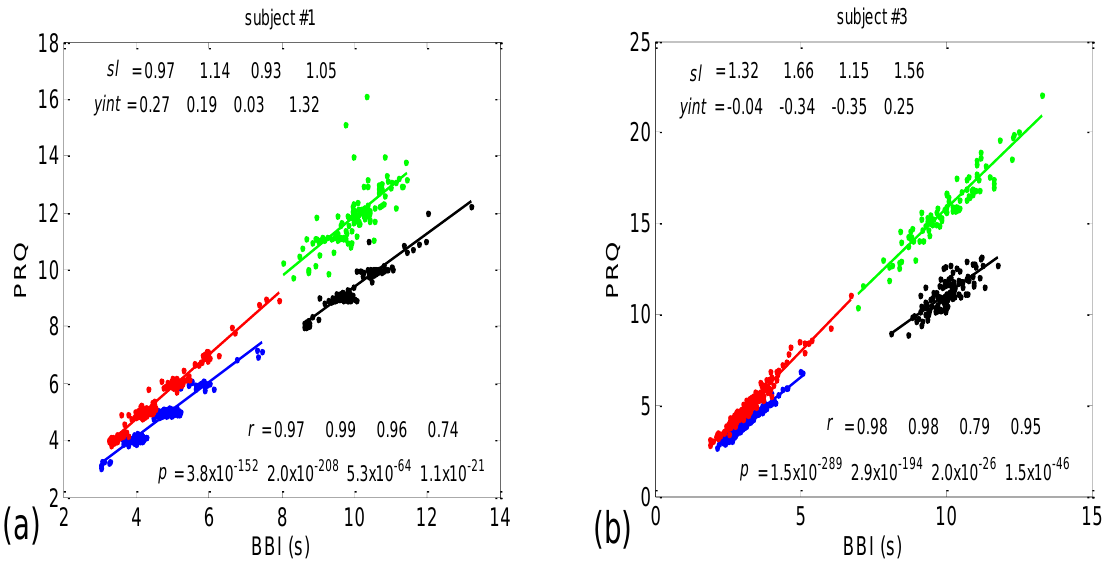
Figure 1. Two scatter plots of the BBI vs. PRQ correlations in two different subjects. ( a ) A case study with quantized PRQ values; ( b ) a case study with continual point distributions. Blue — supine; red — standing; black — supine, with slow 0.1 Hz breathing; green — standing with slow 0.1 Hz breathing. Linear regression slopes ( s l ); Y — intercepts ( yint ). Pearson’s coefficient of linear correlation ( r ) and regression significance ( p ) are also indicated for the four states, respectively, in the order indicated above.